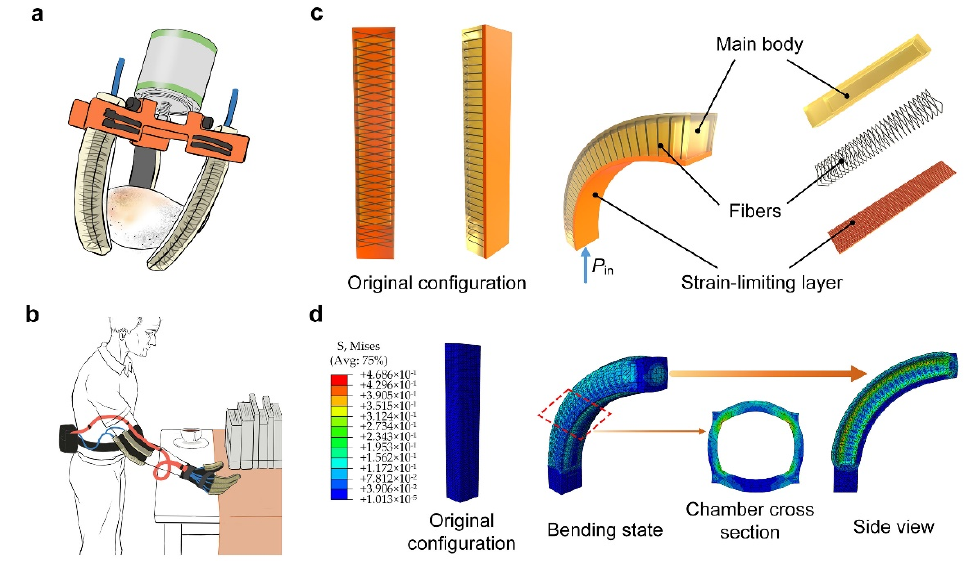
Figure 1. Application scenarios and characteristics analysis of the soft pneumatic actuators. ( a , b ) Soft actuators are applied to a robotic gripper and a wearable exoskeleton. ( c ) Bending display of a fiber-reinforced soft actuator with rectangular cross-section, where P in is the air pressure. ( d ) FE simulation of the fiber-reinforced soft actuator ( P in = 64 kPa), where the air channel modeling is ignored, and the fibers are hidden from the results.